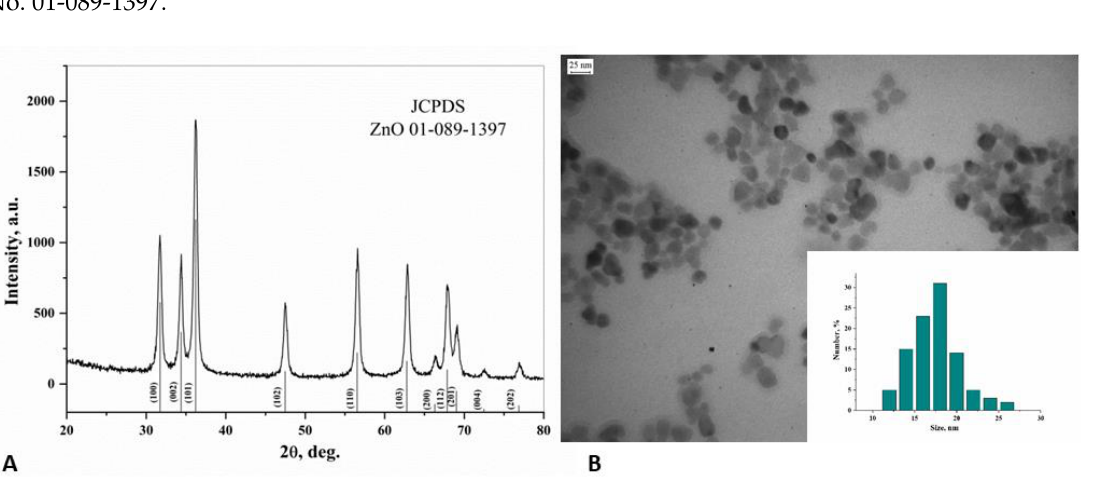
Figure 1. Di ff raction pattern ( A ) and TEM image ( B ) size distribution (insertion) of ZnO Figure 1. Diffraction pattern ( A ) and TEM image ( B ) size distribution (insertion) of ZnO nanocrystals.